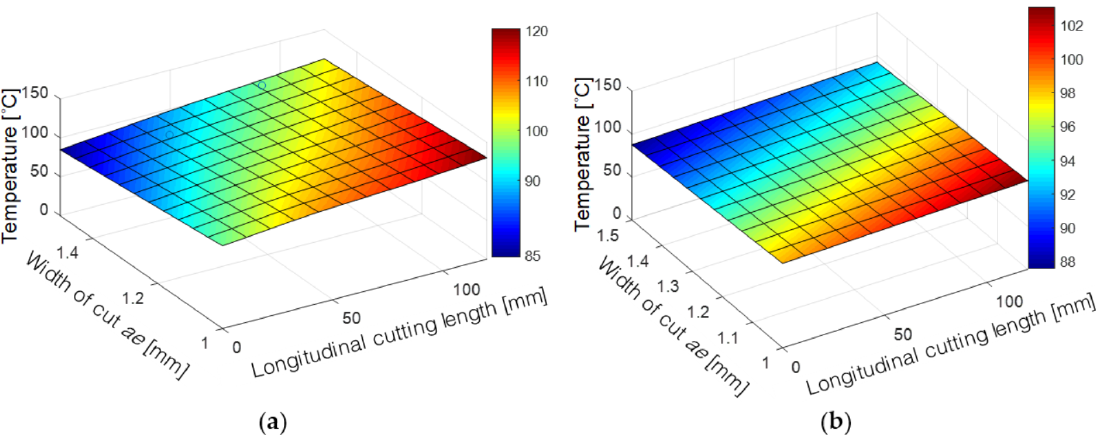
Figure 8. Cutting temperature profile for the Ti6Al4V plaque for an ft of 0.05 mm/tooth, v of 175 m/min and an ae of 1 mm: ( a ) 3D surf mesh cutting temperature for tool2; ( b ) 3D surf mesh cutting temperature for